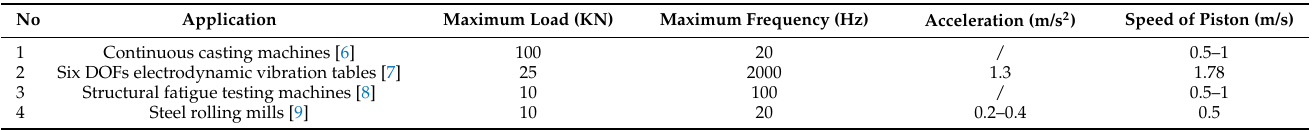
Table 1. Working parameters of servo-hydraulic cylinders in some metallurgical